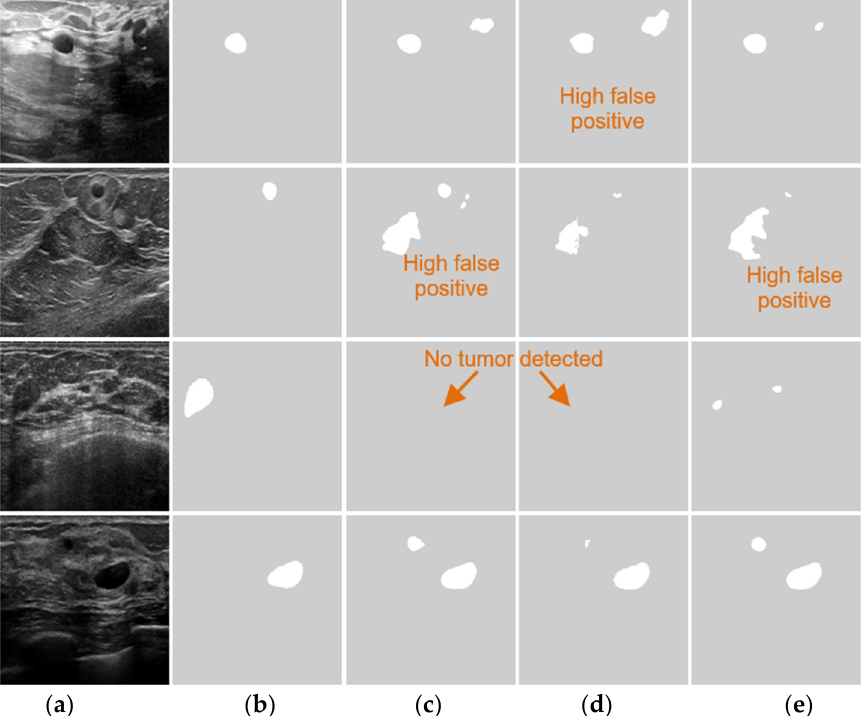
Figure 1. Performance of state-of-the-art approaches for segmenting breast tumors with different sizes. GT: Ground truth. ( a ) BUS Images; ( b ) GT; ( c ) DenseU-Net; ( d ) CE-Net; and ( e ) RDAU-Net. The arrows point to BUS images with no tumor detected.